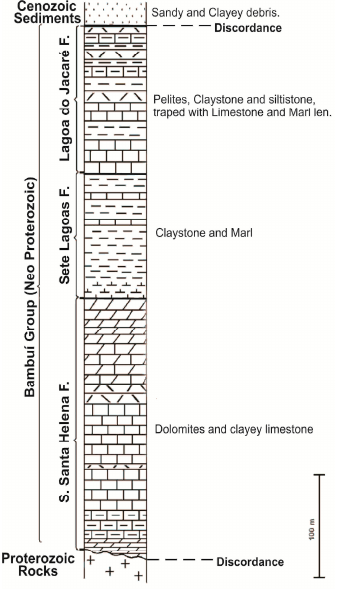
Figure 2. Simplified stratigraphic log of the study site, based on [35,36].